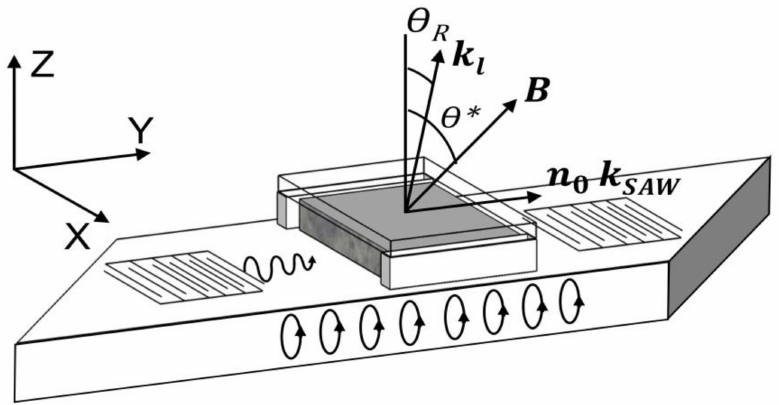
Figure 1. Schematic arrangement of nematic liquid crystals (NLC) cell on LiNbO 3 delay line for